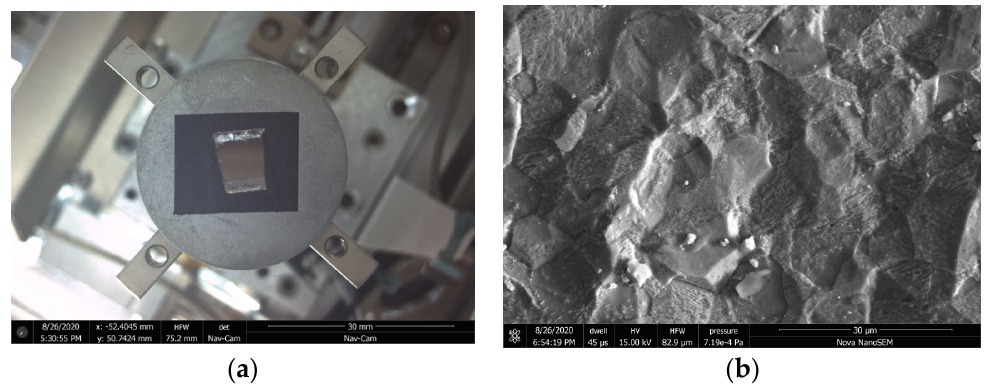
Figure 4. Image ( a ) and morphology ( b ) of the specimen of 14 mm diameter pipeline.